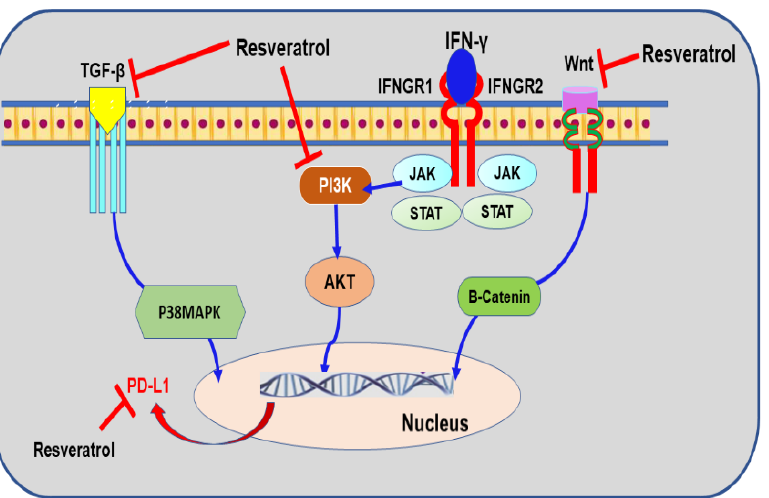
Figure 6. The mechanisms of resveratrol-mediated programmed death-ligand 1 (PD-L1) inhibition in breast cancer cells. Interferon-gamma, IFN- γ ; IFN- γ receptor 1/2, IFNGR1/2; transforming growth factor-beta, TGF- β ; Janus kinase, JAK; signal transducer and activator of transcription, STAT; phosphoinositide 3-kinase, PI3K; protein kinase B, AKT; mitogen-activated protein kinase, MAPK.